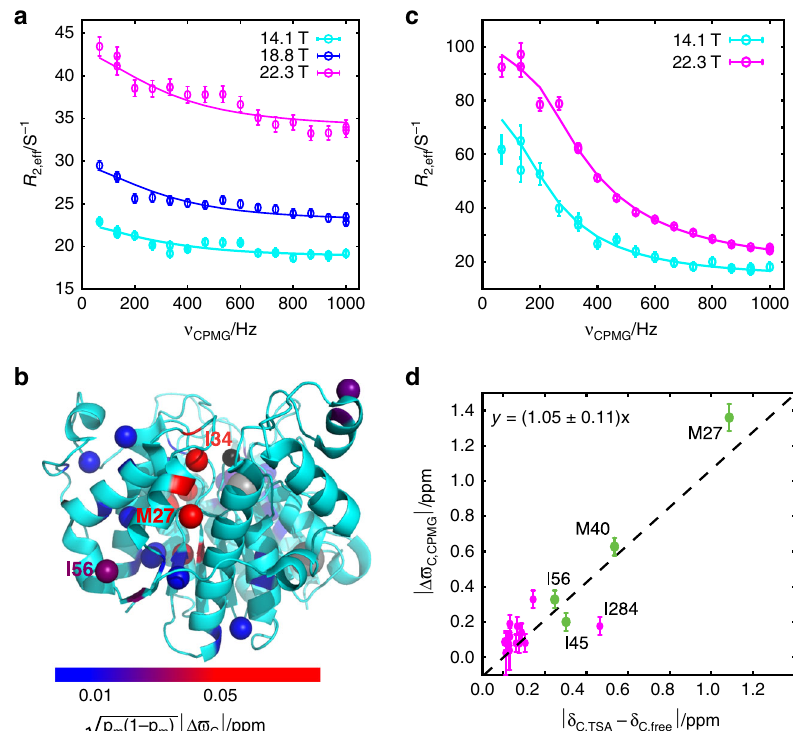
Fig. 2 HDAC8 is in exchange with an alternative state. a Methyl multiple-quantum CPMG relaxation dispersion pro fi les for M27 13 C ε H 3 of free HDAC8. The curved relaxation dispersion pro fi les reveal that the major state is in exchange with a low-populated minor state. b Structural representation (PDB: ffiffiffiffiffiffiffiffiffiffiffiffiffiffiffiffiffiffiffiffiffiffi p p ð 1 (cid:1) p Þ j Δ ϖ j parameters obtained from the CPMG relaxation dispersions, showing the sites affected by the exchange, Supplementary 2v5w 15 ) of the m m C Table 1. c Multiple-quantum relaxation dispersion pro fi les of M27 13 C ε H 3 for TSA-bound HDAC8. In a , c , circles represent experimental data, vertical lines represent the standard derivation (s.d.) and the solid line is the result of a least-squares fi t to a two-state model (see text). d Correlation between 13 C chemical shift differences between free and TSA-bound HDAC8, and | Δϖ | obtained from CPMG relaxation dispersion experiments on TSA-bound HDAC8. Vertical lines represent the standard derivation (s.d.) of the derived | Δϖ | parameters and data points in green are sites located in or near the helix1-loop1- helix2 region.